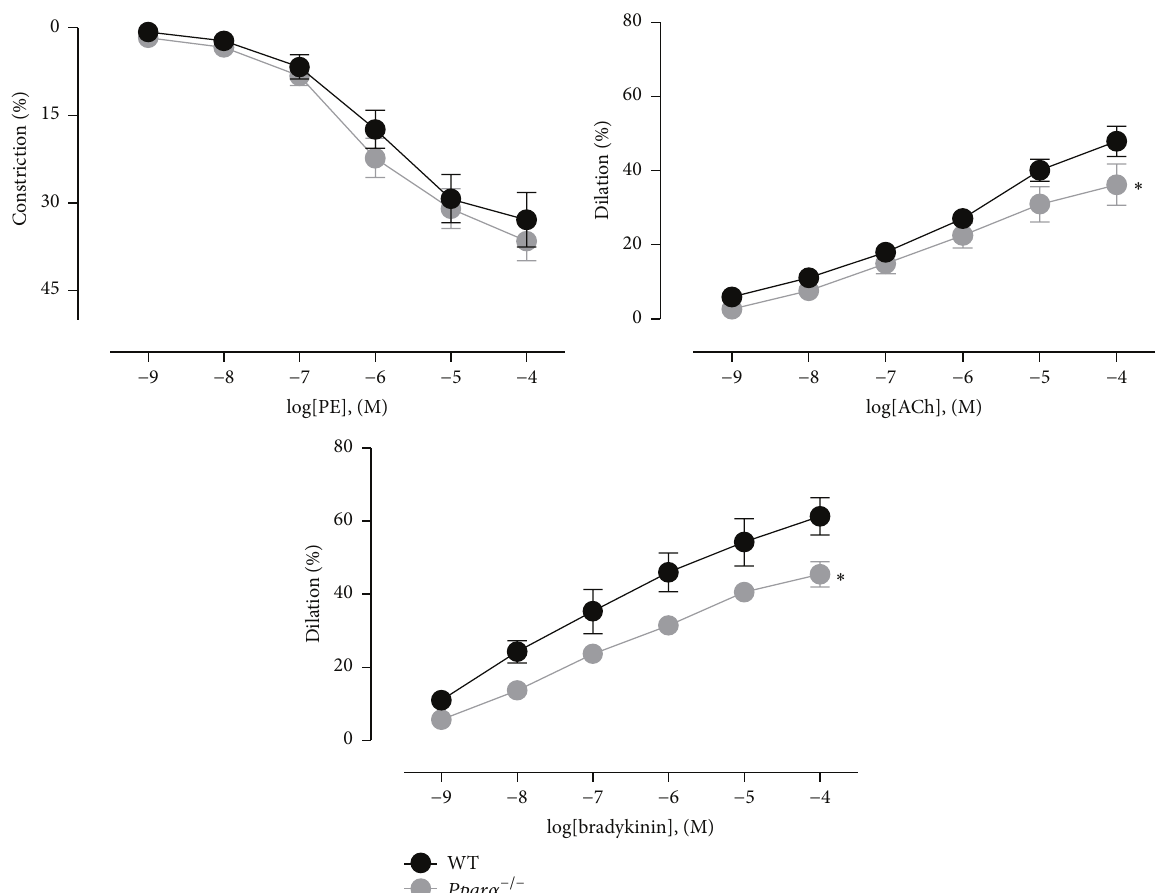
Figure 2: Impaired endothelium-dependent dilations in MCAs of Ppar 𝛼 −/− mice. Contractile response curves to phenylephrine (PE) and dilatory response to ACh and bradykinin on PE- preconstricted middle cerebral artery (MCA) of WT and Ppar 𝛼 −/− mice using isobaric myography. ∗ denotes statistical significance from WT mice ( 𝑝 < 0.05 ; 𝑛 = 5 animals). Data are means ±